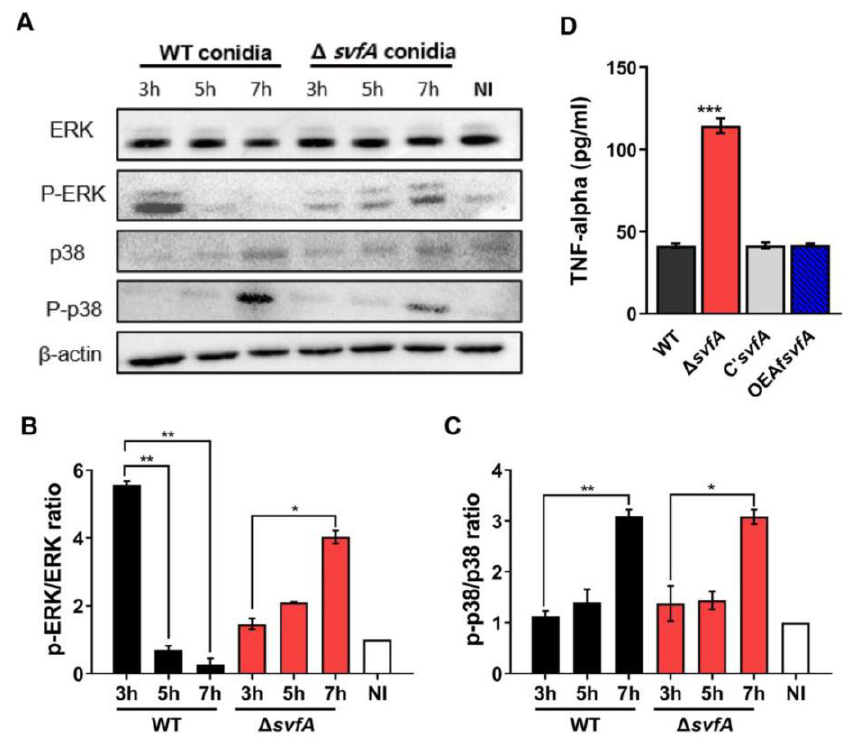
Figure 6. Effect of MAPK phosphorylation and TNF cytokine production from alveolar macrophages challenged with WT and ∆ svfA conidia. ( A ) Phosphorylation of ERK and p38 after stimulation of MH-S cells with conidia detected with Western blotting. ( B , C ). The level of phosphorylation was quantified after normalization to the level of total ERK or p38, respectively. ImageJ software was used. * p < 0.05, ** p < 0.01. ( D ) Production of TNF- α . Macrophages were challenged with 10-fold conidia and incubated for 6 h. The release of the cytokine was measured with ELISA. N = 21 – 34. *** p ˂ 0.001.